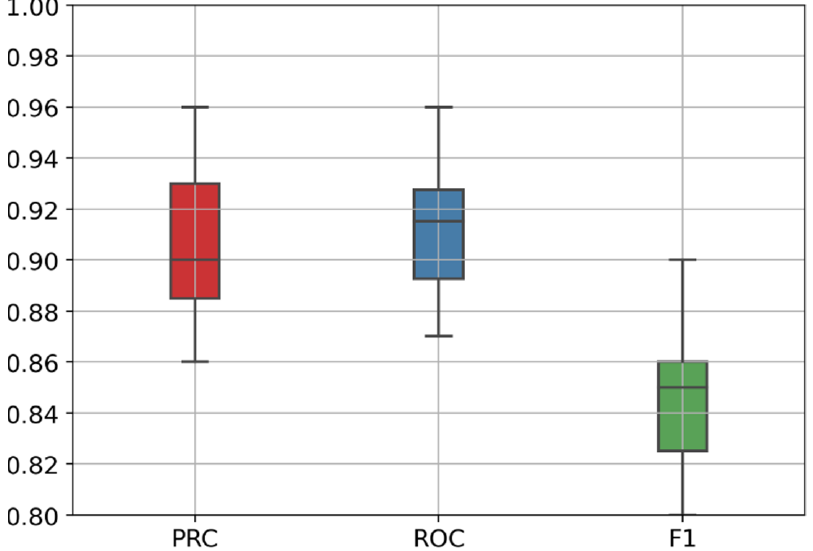
Figure 6. Boxplot of the stratified 10-fold cross-validation results showing PR-AUC, ROC-AUC, and F1-score ranges.